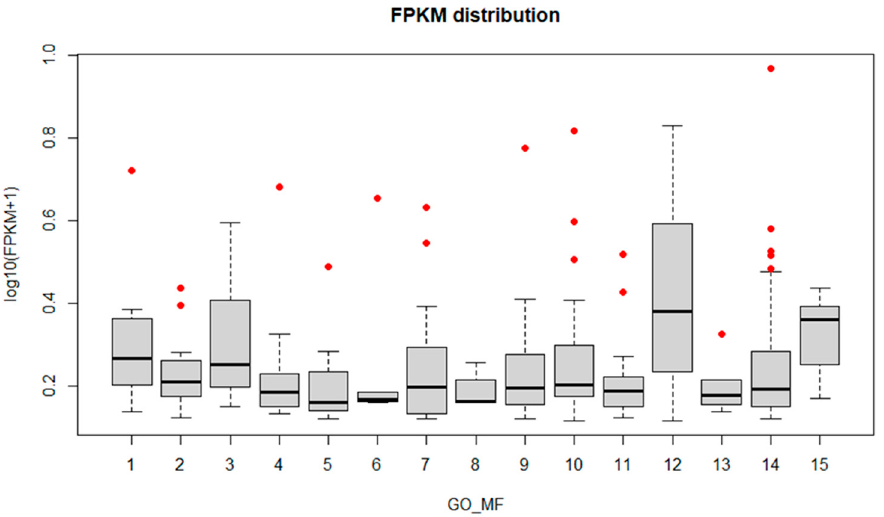
Figure 5. FPKM distribution of the most enriched GO terms (Molecular Function). The x-axis corresponds to the enriched terms with more than five Unigenes, the y -axis is the FPKM value ex-